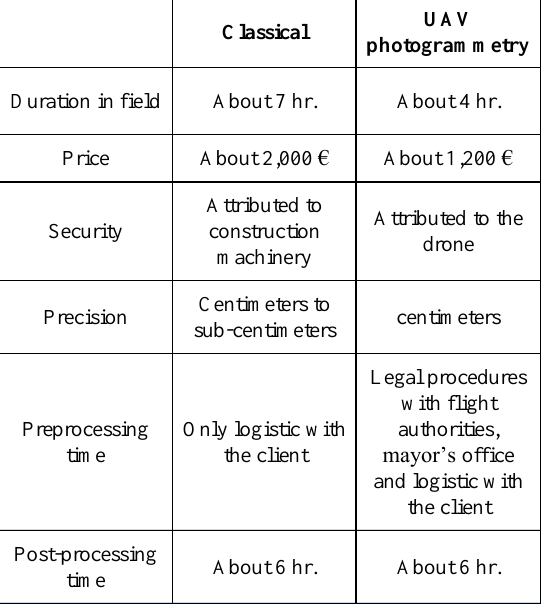
Table 5: The differences between classical and UAV